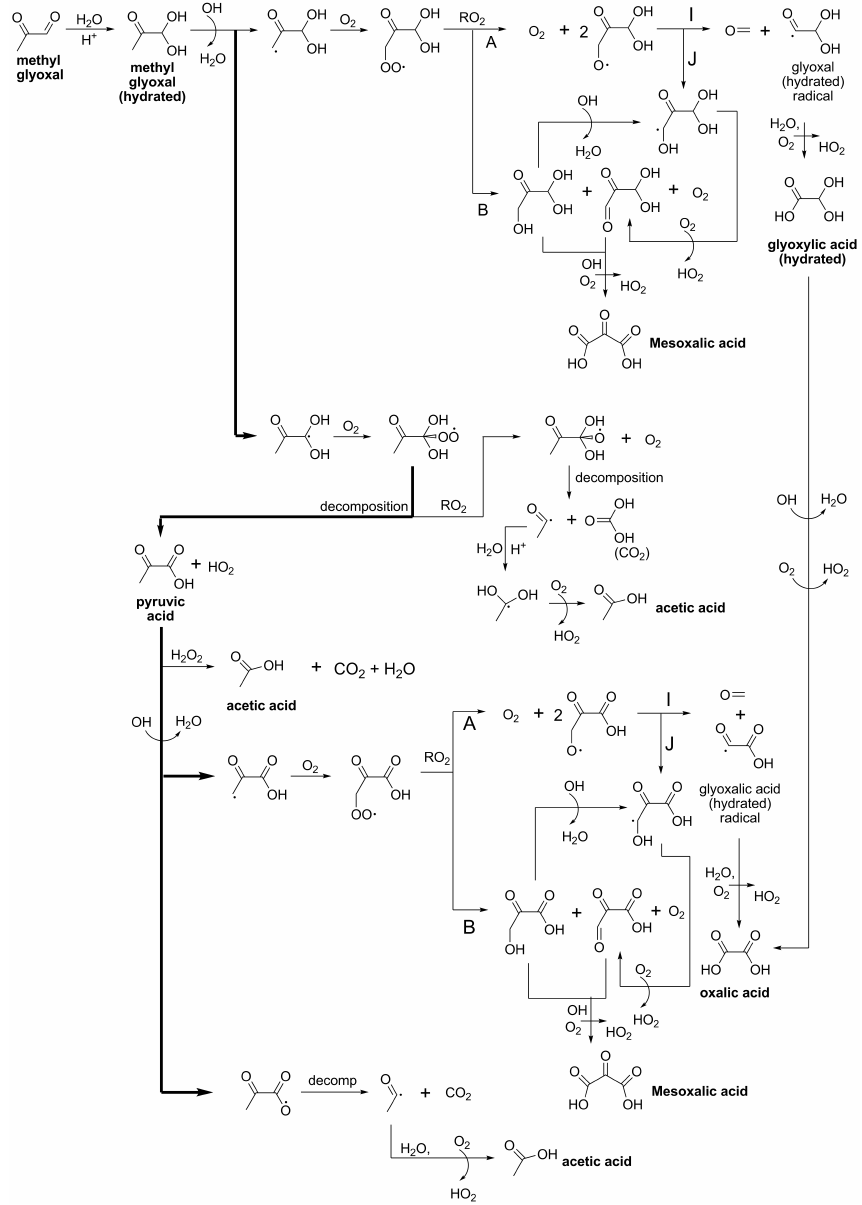
Fig. 3. Reaction mechanisms for the reactions of methylglyoxal with OH radicals in the aqueous phase. The bold arrows represent dominant